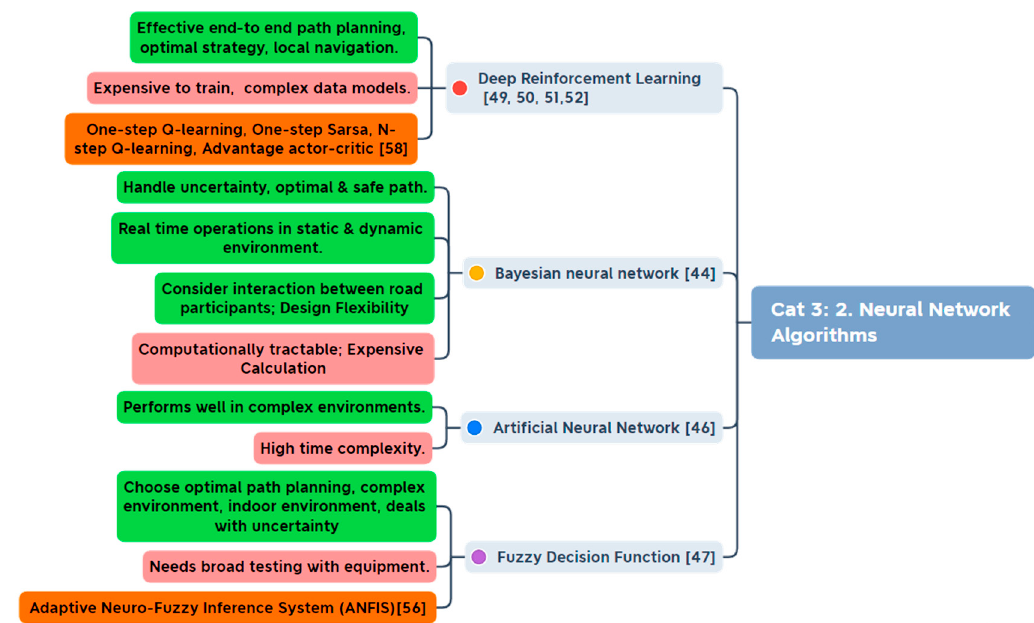
Figure 7. Neural network algorithms with the main advantages and drawbacks.